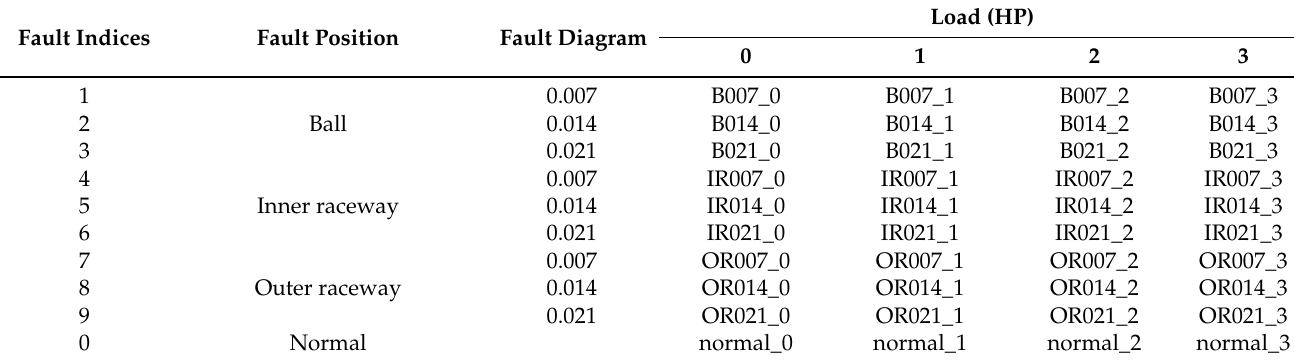
Table 1. CWRU bearing dataset.